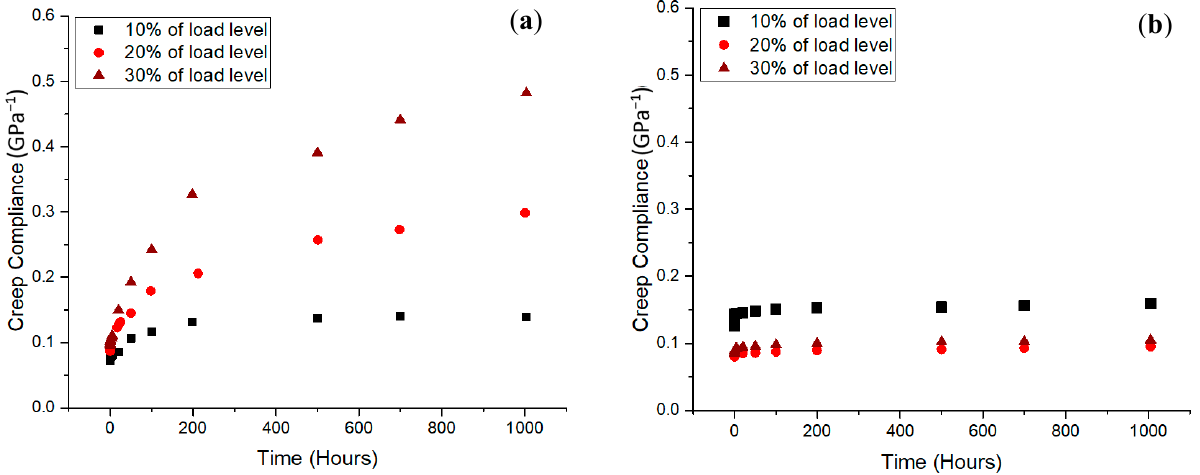
Figure 7. Creep compliance against time at different load levels for ( a ) wood and ( b ) pGFRP speci- mens. Reproduced with copyright permission from Asyraf et al. [26].